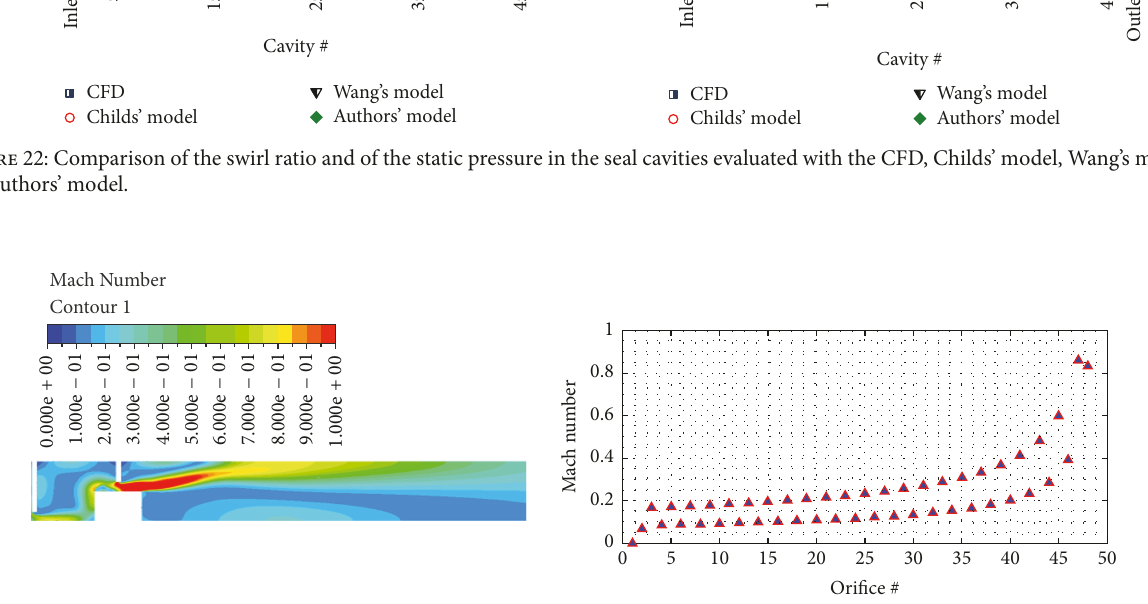
Figure 23: Mach number evaluated using the CFD and the authors’